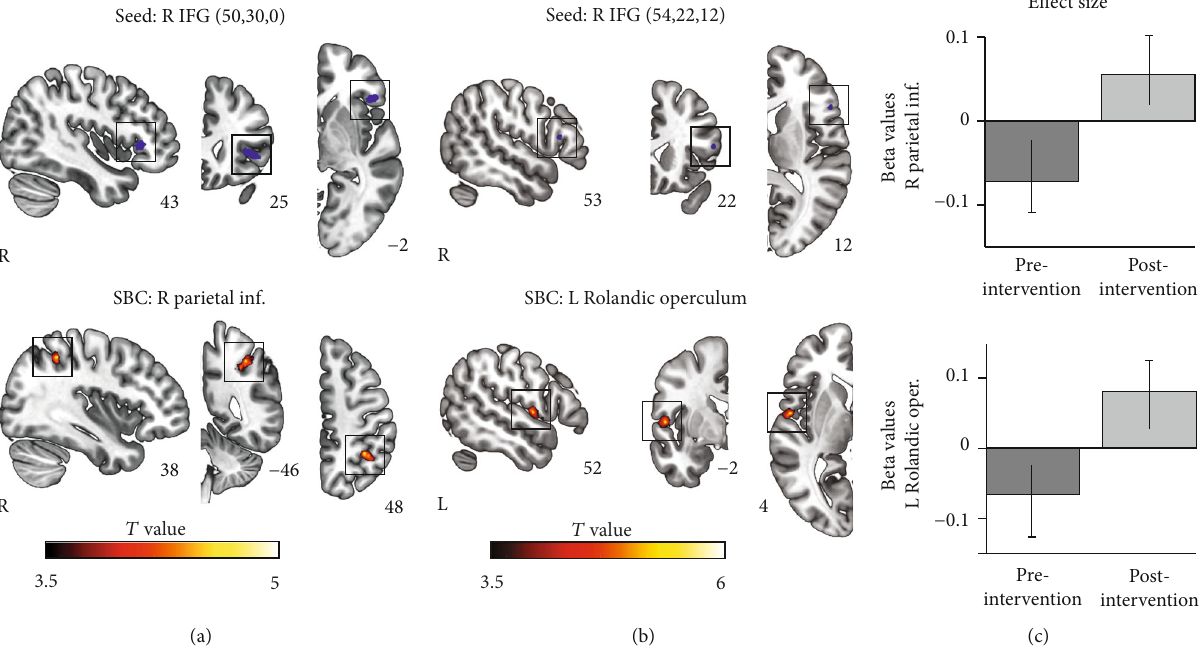
Figure 4: Changes in seed-based connectivity induced by the neurological music therapy intervention. (a) Top : R IFG mask used as seed with peak coordinates x = 50 , y = 30 , and y = 0 , overlaid on the Montreal Neurological Institute (MNI) template; bottom : statistical map showing the p < 0 : 05 FDR-corrected cluster in the R parietal Inf. (b) Top : R IFG mask used as a seed with peak coordinates x = 54 , y = 22 , and y = 12 , overlaid on the MNI template; bottom : statistical map showing the p < 0 : 05 FDR-corrected cluster in the L Rolandic Operculum. (c) E ff ect size plots displaying the functional connectivity (mean beta values) of each signi fi cant cluster in the pre-intervention relative to the post- intervention period. IFG: Inferior Frontal Gyrus; Parietal Inf.: inferior parietal lobule; R: right; L: